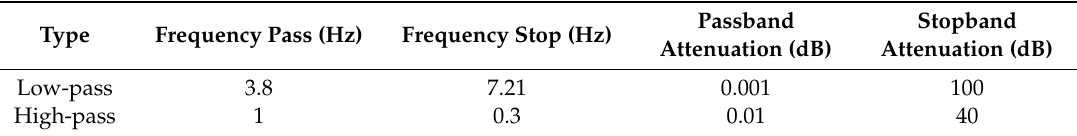
Table 1. PPG filtering: FIR filter configuration parameters.